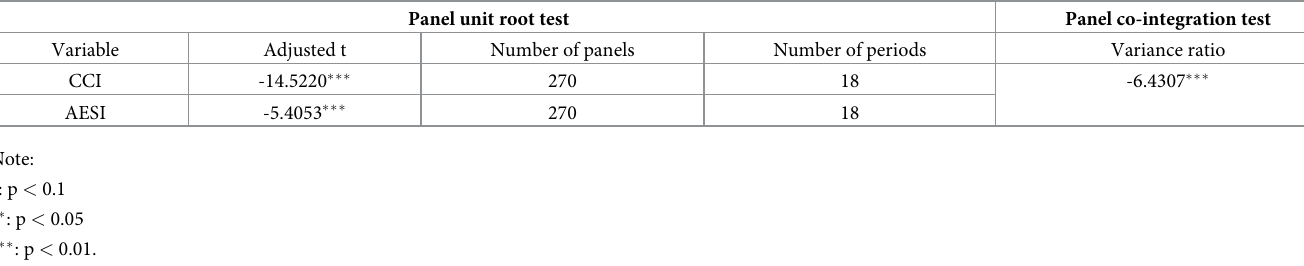
Table 1. Results of panel unit root test (PURT) and panel co-integration test (PCIT) of CCI and AESI.